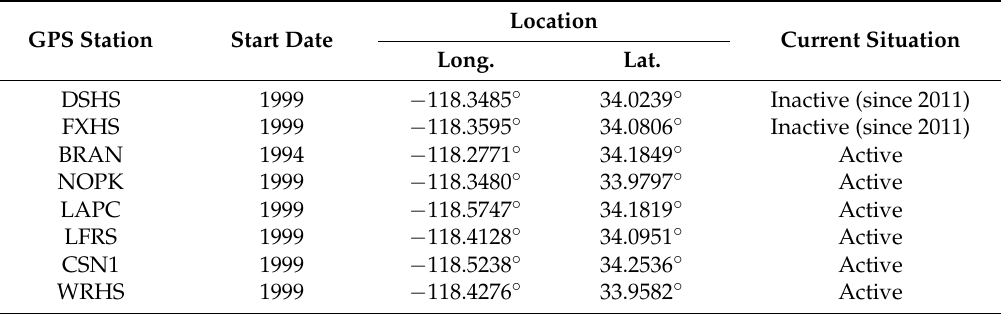
Table 1. GPS Stations in the Study Area.